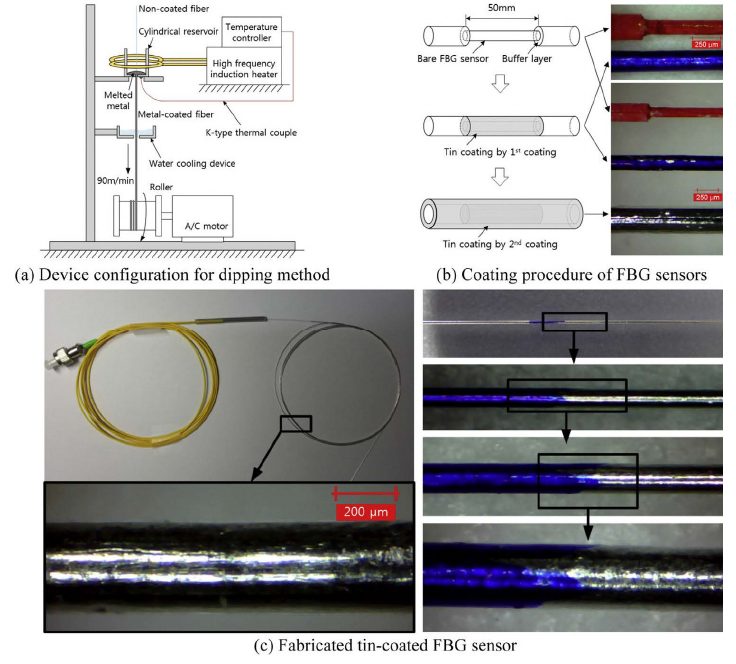
Figure 8. Coating procedures and fabricated sensors [50].